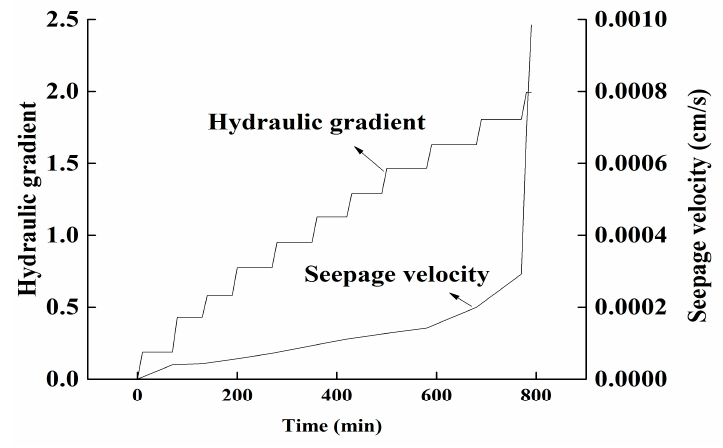
Figure 4. Hydraulic gradient and seepage velocity-t curve of II-1.